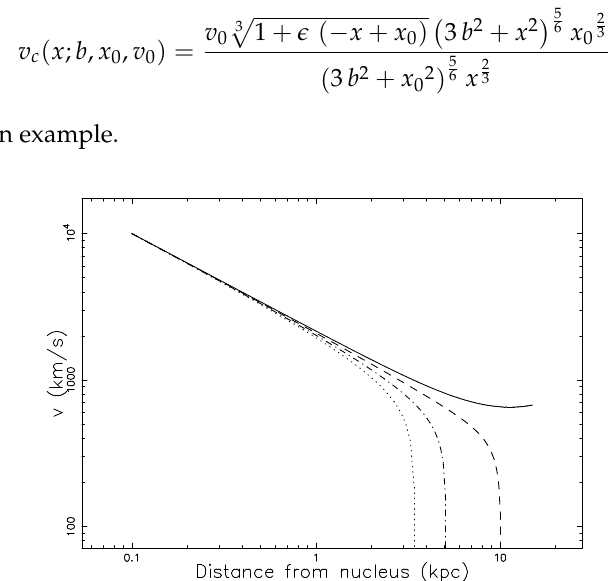
Figure 4. Velocity corrected for radiative losses, i.e., velocity to second order, Equation (40), as a function of the distance, with parameters as in Table 1: (cid:101) = 0 full line, (cid:101) = 1.0 × 10 − 4 dashed line, (cid:101) = 2.0 × 10 − 4 dotted-dashed line, and (cid:101) = 3.0 × 10 − 4 dotted line.